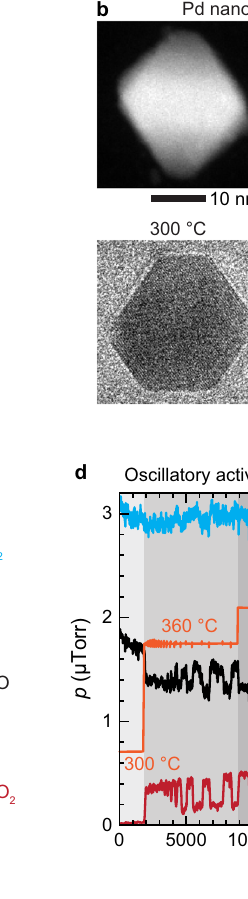
Fig. 1|Operandotransmissionelectron microscopy(TEM)ofPdnanocubeand at different temperatures as indicated by orange step curves. The reaction oscil- nano-octahedron catalysts during a CO oxidation reaction. STEM and TEM lates for the nano-octahedrons, while the nanocubes do not show such oscillatory images of a cuboidal and b octahedron Pd nanoparticles (NPs) at different tem- reactivity. In terms of the NP morphology, the sharp corners of nano-octahedrons peratures and under 760Torr of 10% CO, 18% O 2 , and 72% He gas environment in b become rounded as they switch to a high-activity state at 360°C, whereas the ≈ 0 : 5). Changes in gas composi- corresponding to a gas pressure ratio of p CO = p O nanocubesin a remainunchanged,andtheiractivityincreasesverylittleatelevated 2 tions during the CO oxidation reaction over c nanocubes and d nano-octahedrons